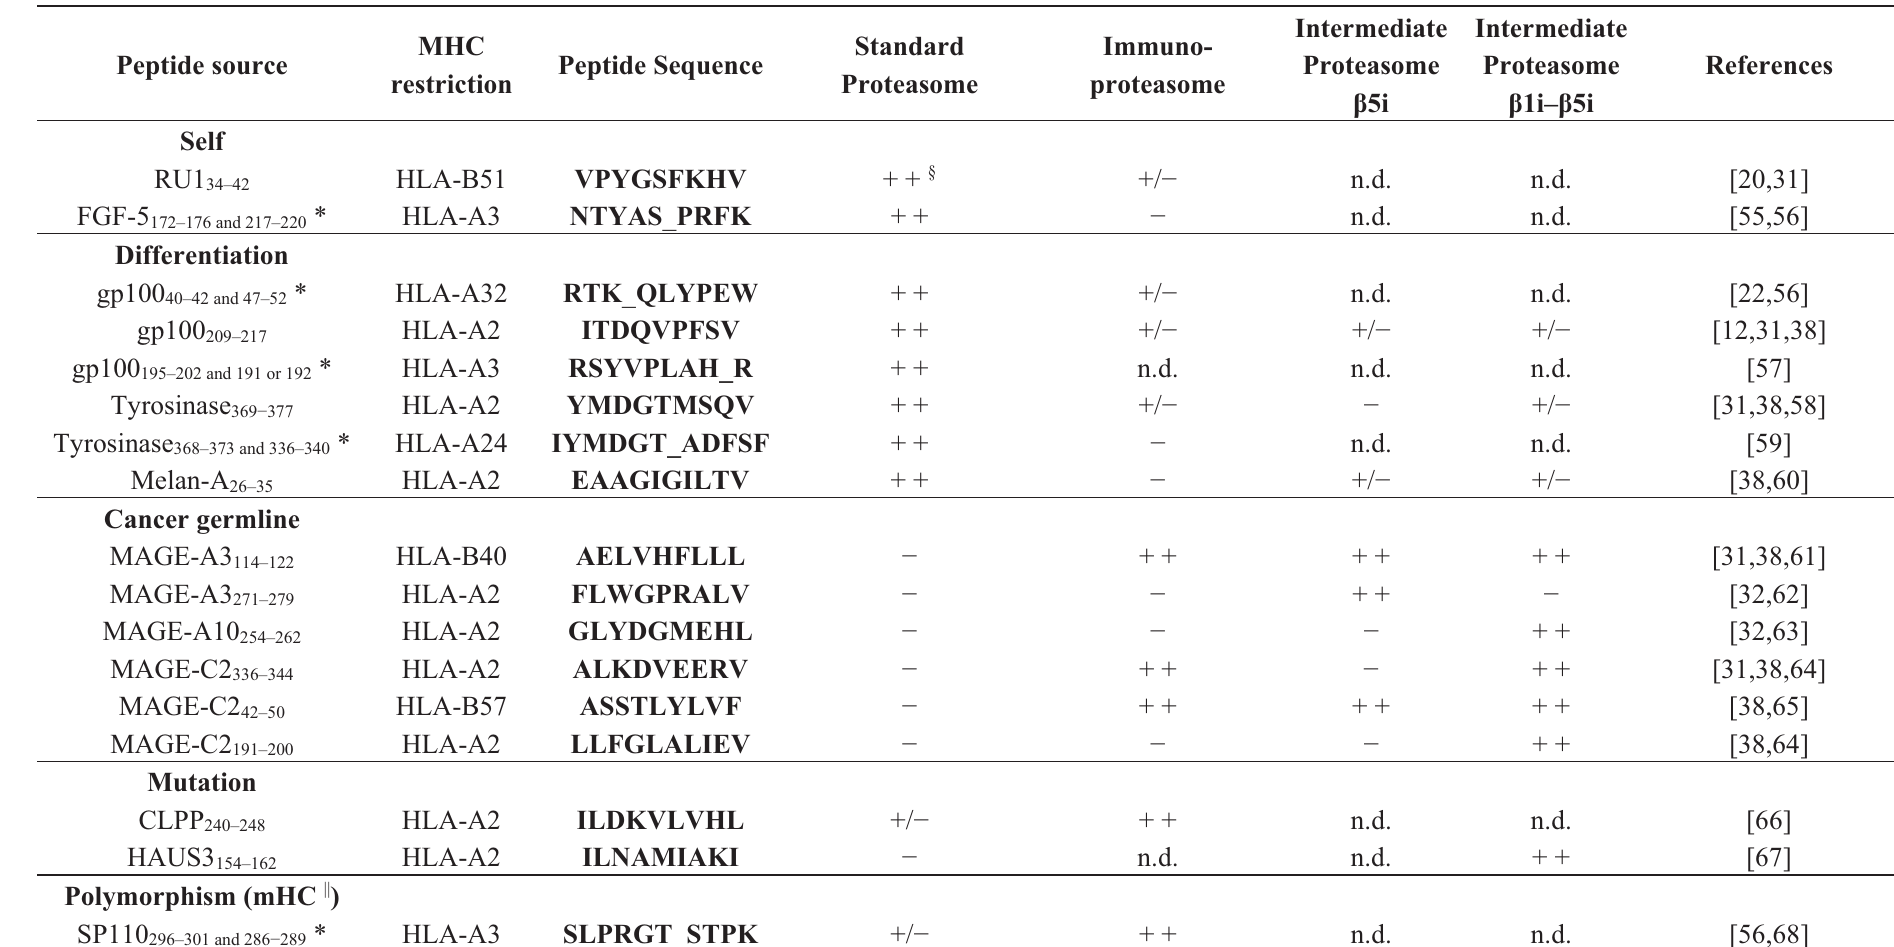
Table 1. Processing efficiency of tumor antigens by the different proteasome